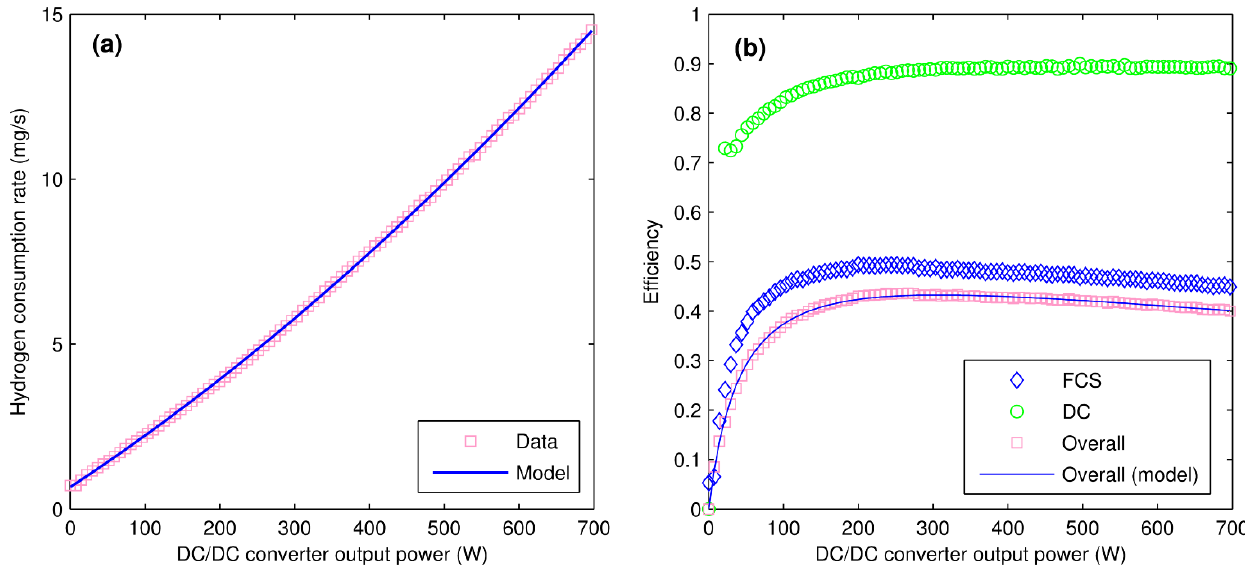
Figure 4. Modeling of the FCS and its DC/DC converter. ( a ) Hydrogen consumption rate; ( b ) Efficiency of FCS and its DC/DC